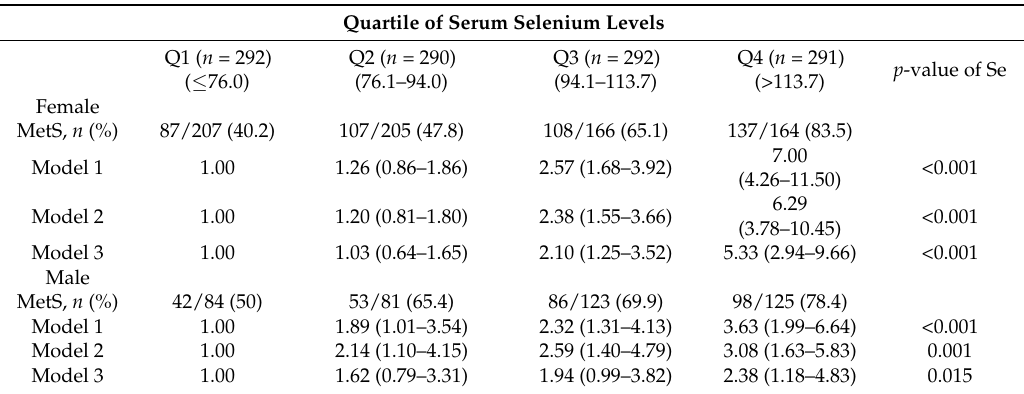
Table 4. Odds ratios (ORs) of having MetS derived from multiple logistic regression analyses in quartiles of serum selenium levels, stratified by